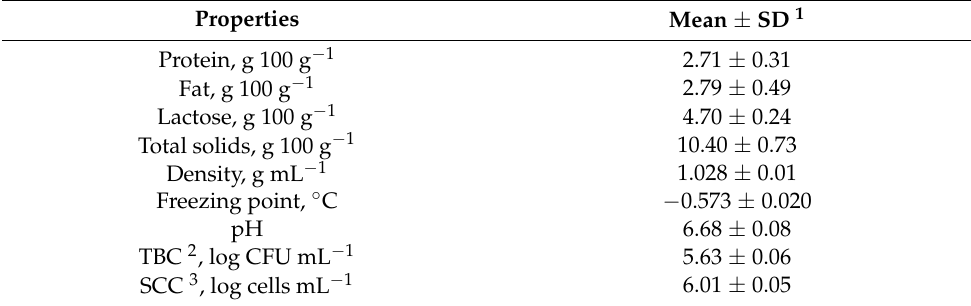
Table 1. Composition and physicochemical characteristic of raw goat’s